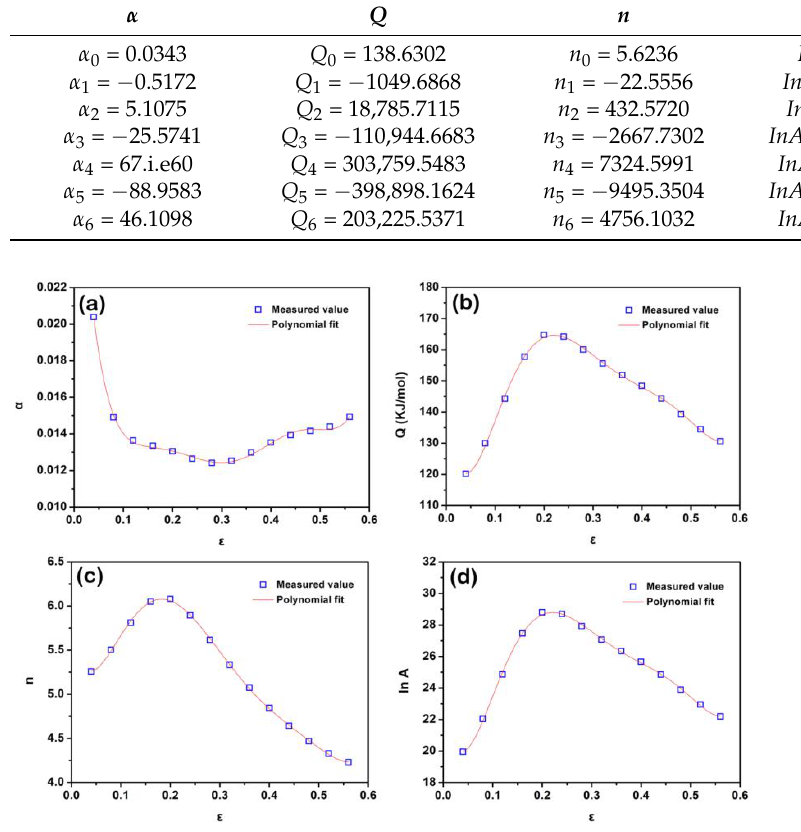
Figure 6. ( a ) α , ( b ) Q , ( c ) n and ( d ) lnA as functions of the true strain ε .